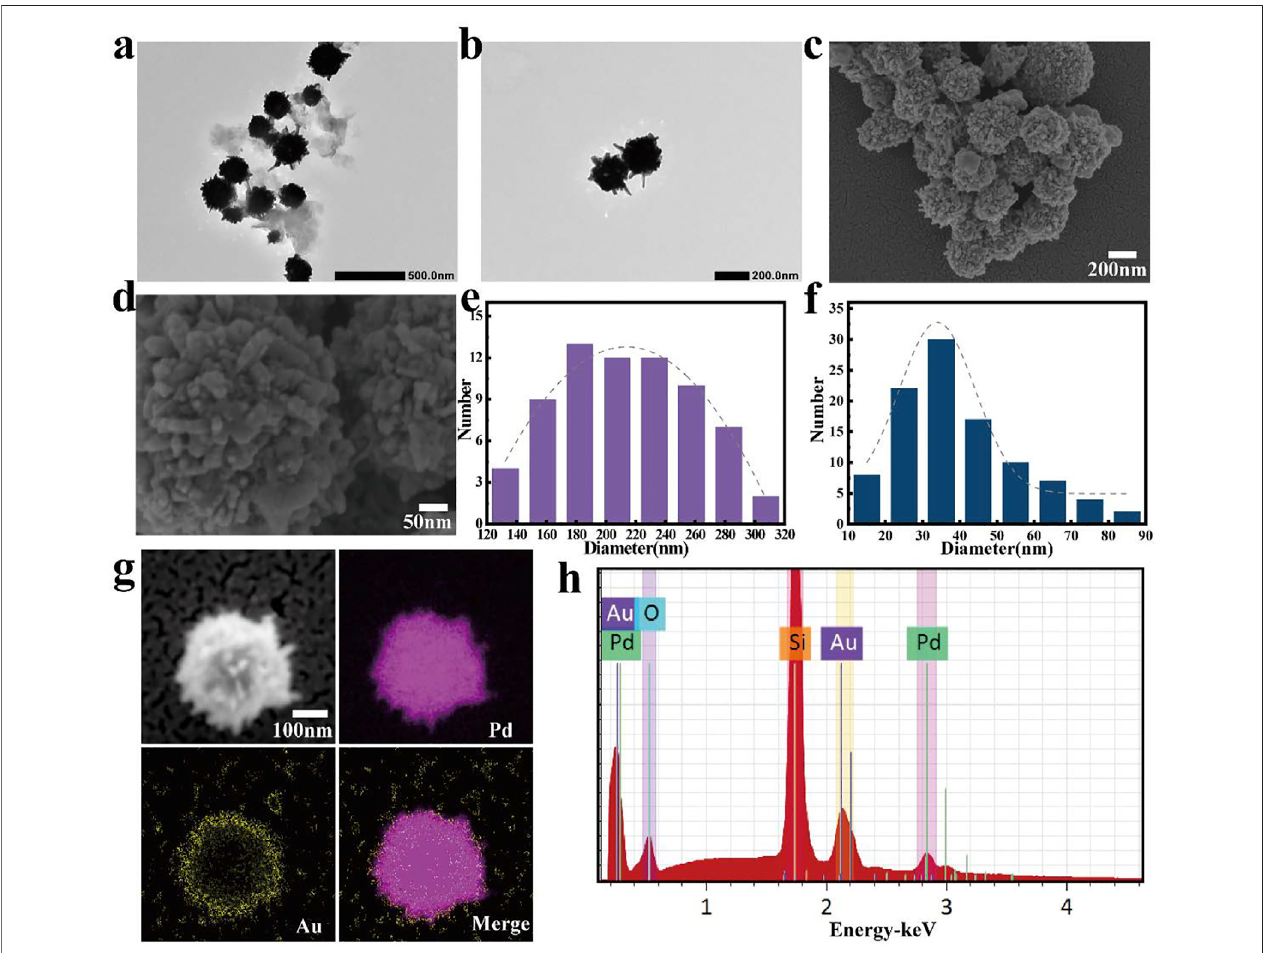
FIGURE 2 | (A,B) TEM images of Pd nanospikes, scale bars were 500 and 200 nm, respectively; (C,D) SEM images of gold (Au)-coated Pd nanoparticles; scale bars were 200 and 50 nm, respectively; (E) Diameter distribution of Pd nanospheres; (F) Length distribution of the spikes dispersed on the surface of the nanospheres (The gray dash line is the corresponding Gaussian fi tting curve); (G) Elemental mapping result of gold (Au)-coated Pd Janus nanomotor (scale bar, 100 nm) and (H) corresponding energy spectra (placed on a silicon